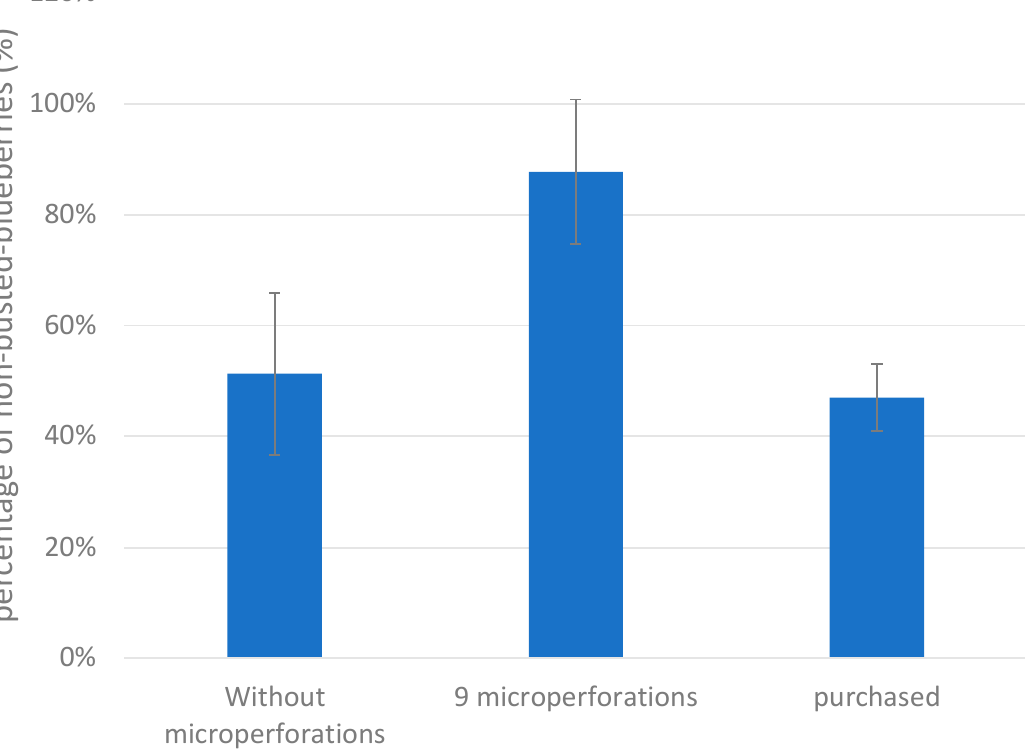
Figure 11. Experimental and statistical analysis of the nonbusted percentage (%) as affected by CO 2 laser microperforations.